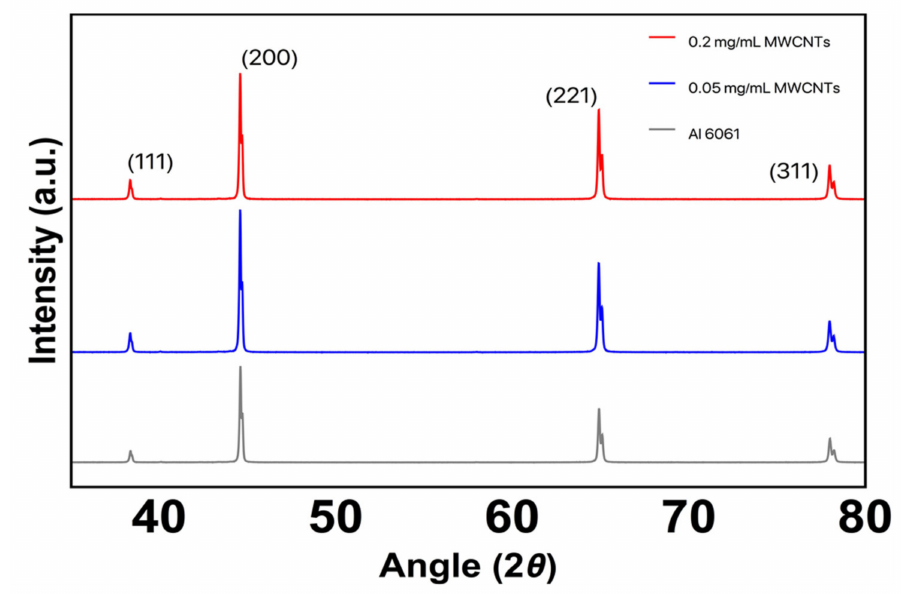
Figure 4. XRD di ff ractograms for Al 6061 and electrodeposited specimens MWCNTs / Al 6061. The XRD di ff ractogram shows the main characteristic reflection planes for aluminum 60161.